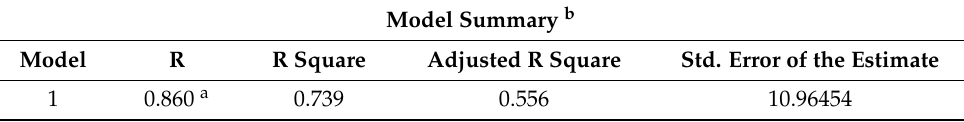
Table 3. Model summary for regression.